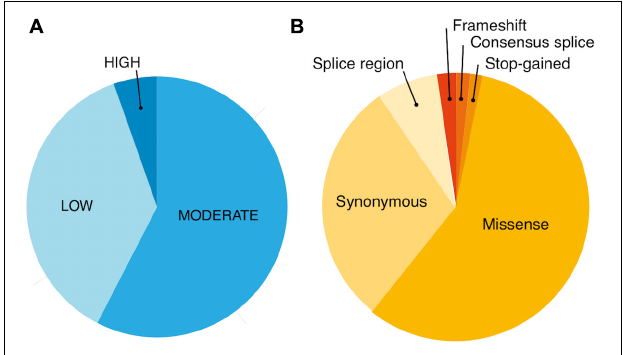
FIGURE 1 | Counts by variant annotation impact (SNPEfff) (A) and variant annotation type (SNPEfff) (B) for rare exonic and splicing variation in 293 pharmacogenes (MAF <